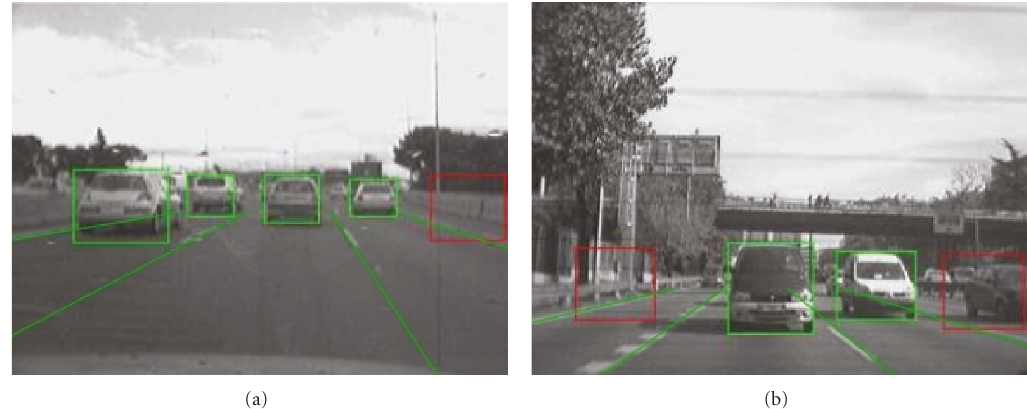
Figure 14: Linear SVM with HOG features classification examples: nonvehicle (red) and vehicle